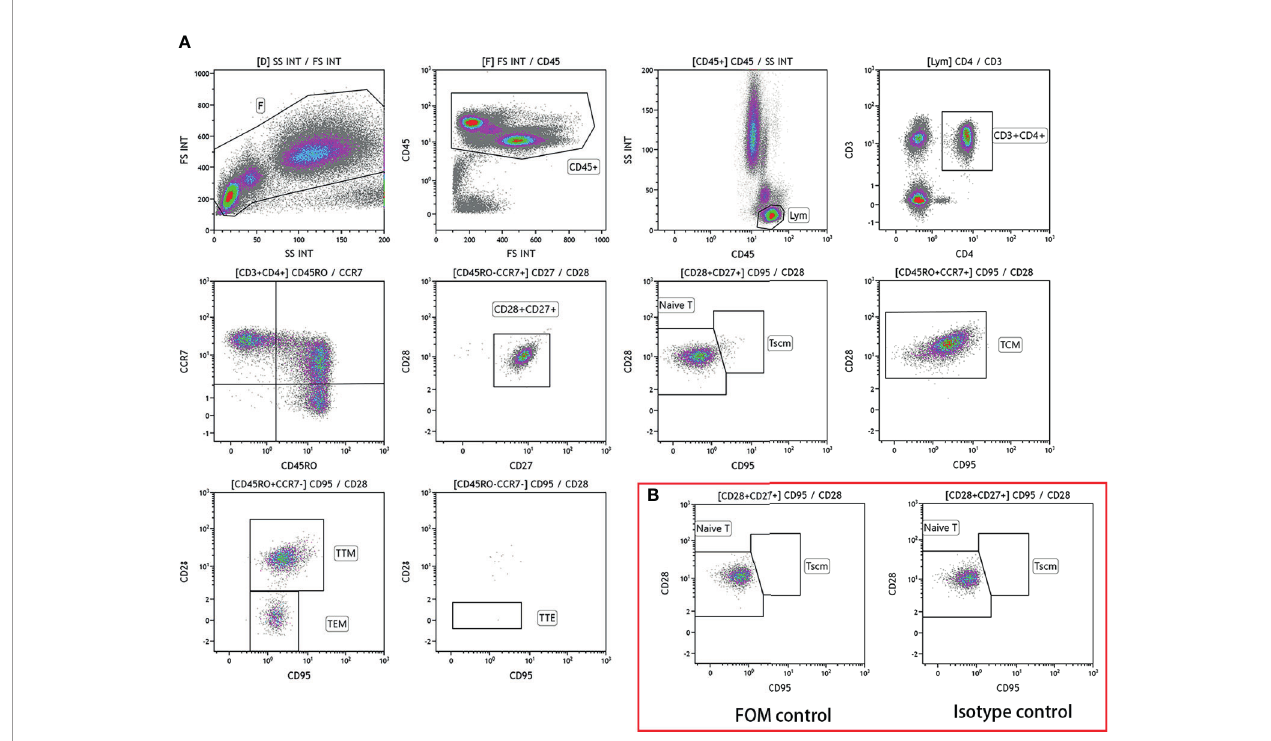
FIGURE 1 | Analysis scheme of CD4 + T lymphocyte subsets in the peripheral blood of patients with colorectal cancer (A) Phenotype of CD4 + T lymphocyte subsets. TSCM, memory stem T cells; TN, naive T cells; TCM, central memory T cells; TTM, terminal memory T cells; TEM, effector memory T cells; TTE, terminal effector T cells. (B) Control